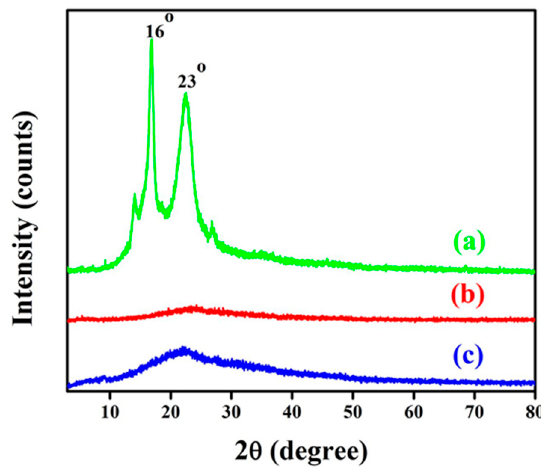
Figure 4. X-ray diffractograms of GNF ( a ) and composites with 5% GNF, composited with PS ( b ) and TS ( c ).